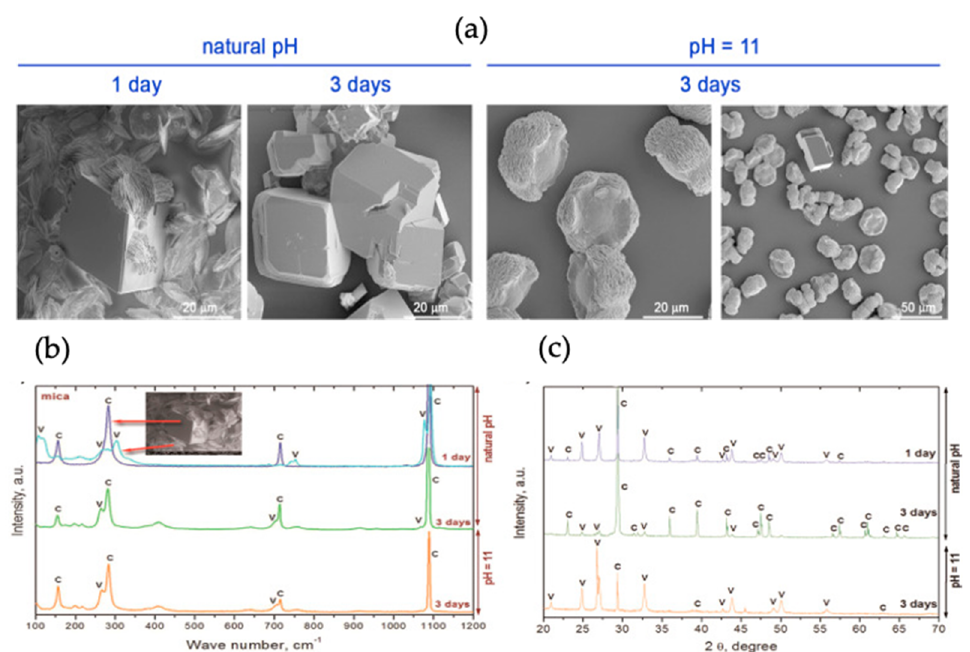
Figure 20. ( a ) Representative SEM images of calcium carbonate microcrystals deposited on the mica surface at natural and basic initial pH, ( b , c ) Raman spectra and XRD spectra of calcium carbonate deposited on bare mica (C-calcite, V-vaterite). The figure is adapted with permission from Reference [29].